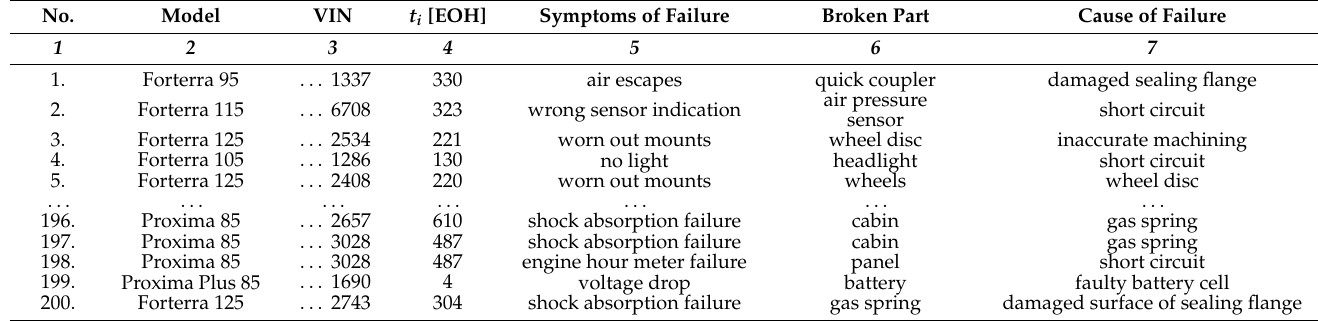
Table 1. Failures data for 200 of different models of Zetor tractors, in time t i